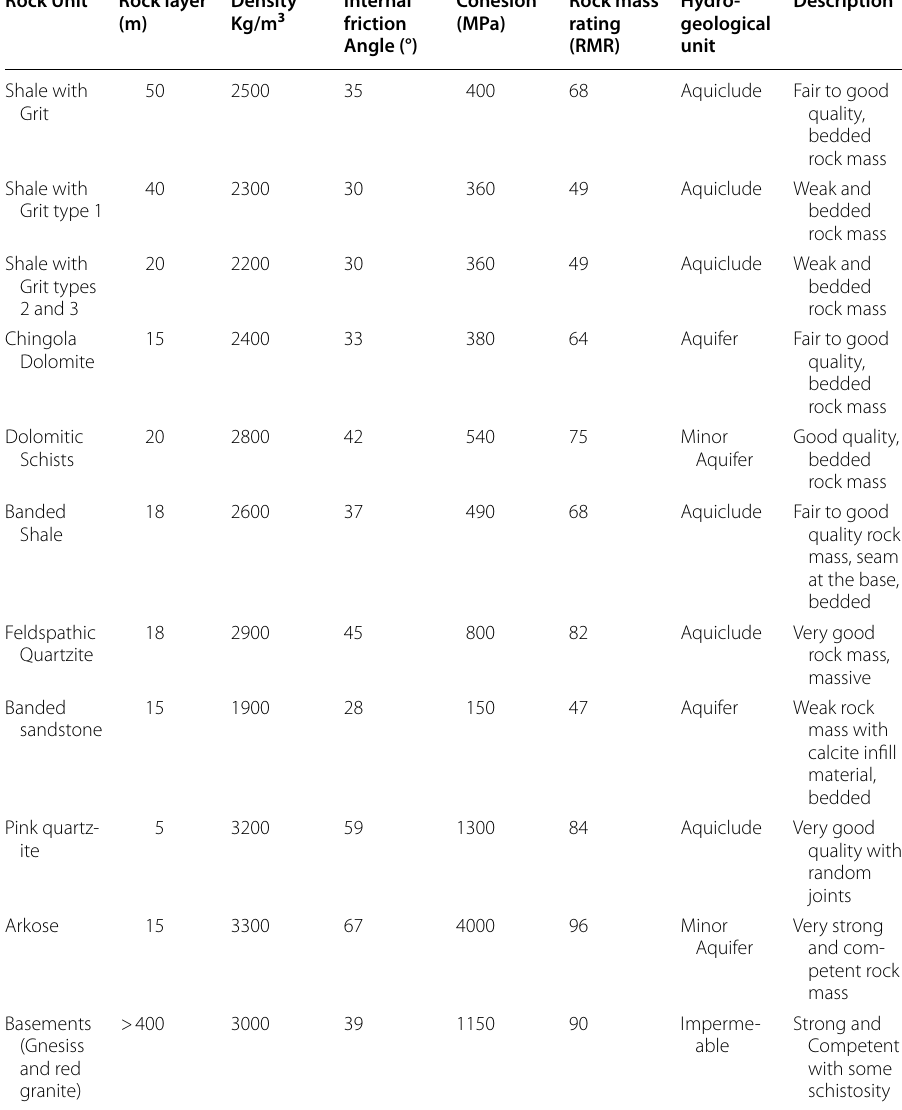
Table 1 The general stratigraphy and rock characteristics Rock